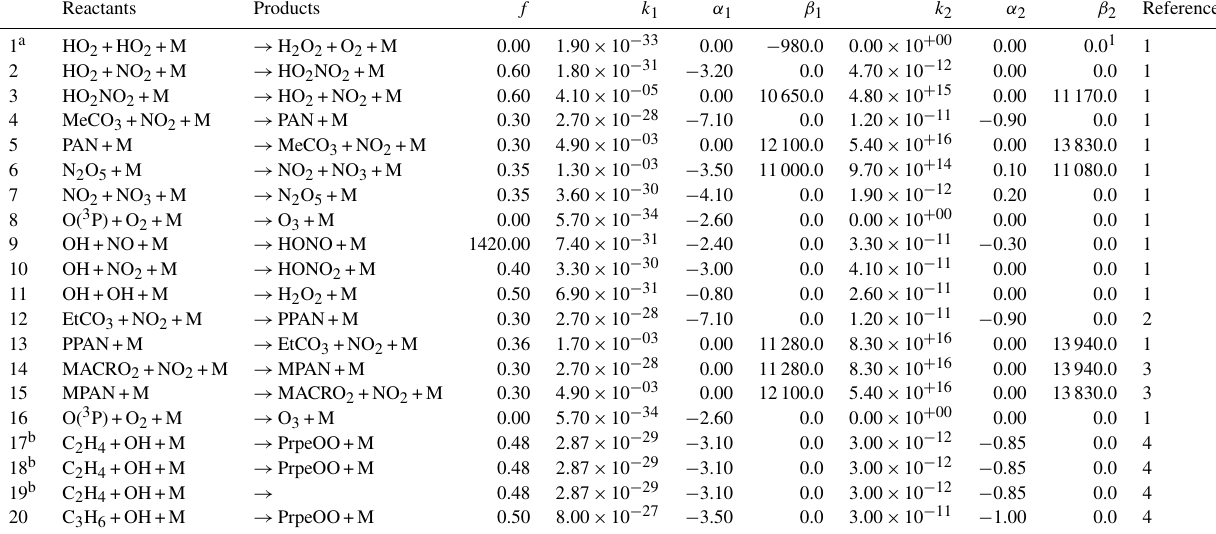
(cid:16) (cid:17) − 1 ] 2 1 +[ log k 0 [ M ] k (cid:17) (cid:16) k ∞ 0 [ M ] F c , 1 + k 0 [ M ] /k ∞ (cid:16) T (cid:17) α 2 (cid:16) − β (cid:17) 2 exp . Reaction T 300